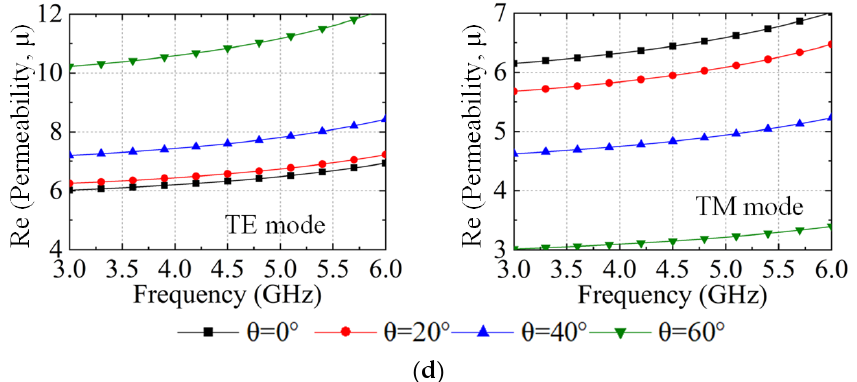
Figure 2. NRMS unit cell with incident angle along the normal direction of the surface: ( a ) the simulation model, ( b ) the S-parameters under TE and TM incidence waves at different incident angles, ( c ) the real part of the permittivity under TE and TM incidence waves at different incident angles, and ( d ) the real part of the permeability under TE and TM incidence waves at different incident angles.